Question: Based on the figure, does the quantity rise or fall?
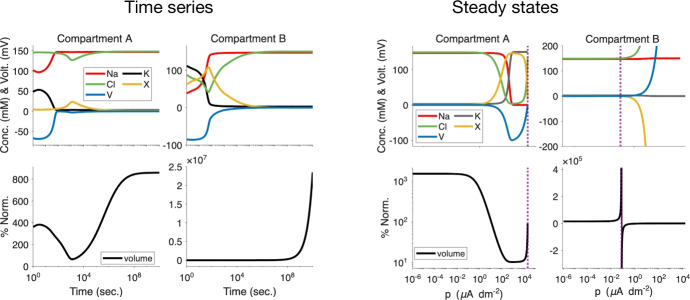
Answer: increasing